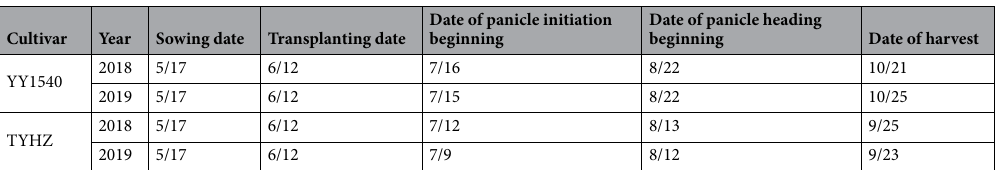
Table 8. Details of the rice growth period in 2018 and 2019.